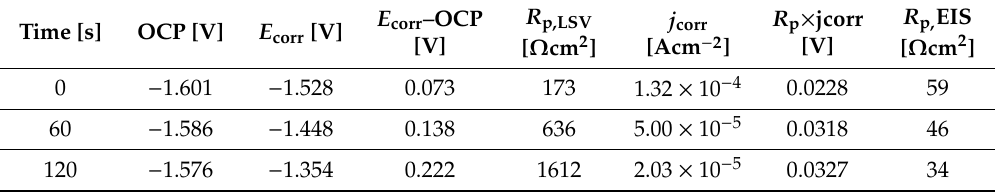
Table 3. Results of the electrochemical experiments carried out on Mg samples subjected to